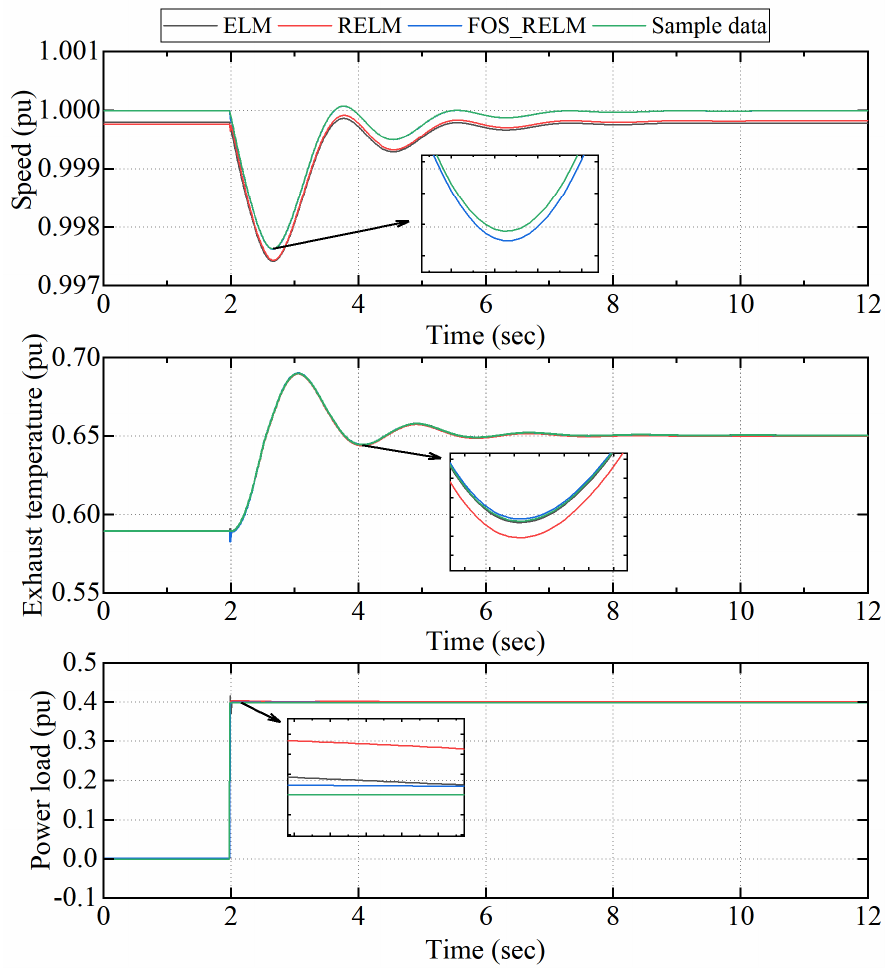
Figure 6. The identification effects of FOS_RELM, RELM, and ELM after changing the ambient tem- perature. Table 3. Identification effects of FOS_RELM, FOS_ELM, and OS_ELM